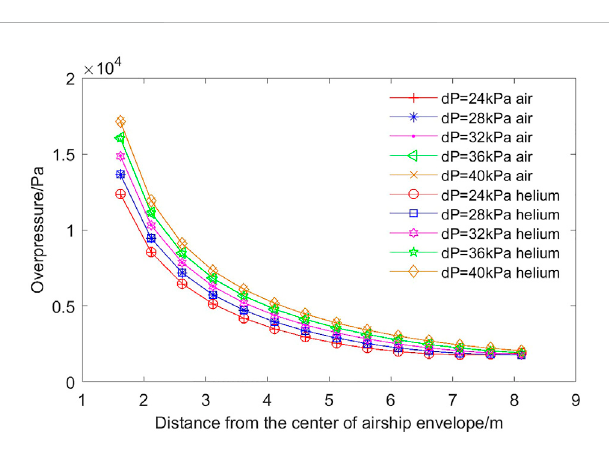
FIGURE 9 Overpressure for envelopes at different pressure differences and sorts of